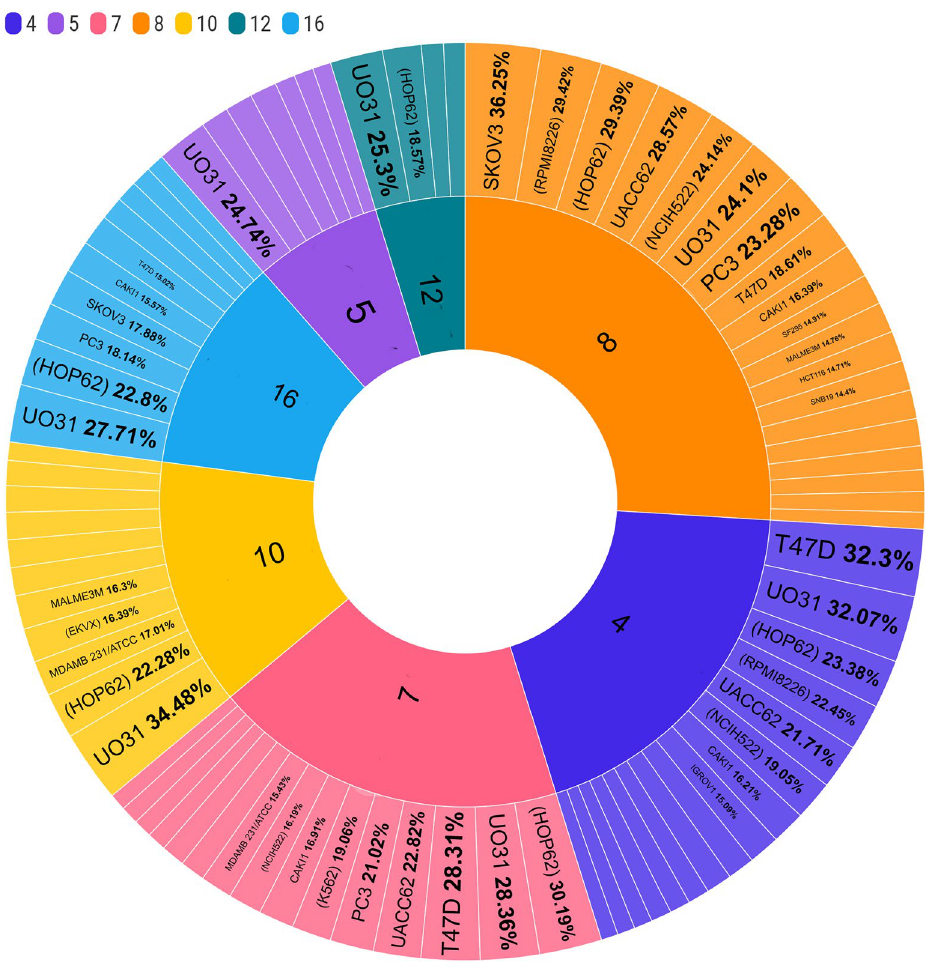
Figure 4. Sunburst chart represents GI% higher than 15% for compounds 4 , 5 , 7 , 8 , 10 , 12 , and 16 against cancer cell lines of the nine tumour